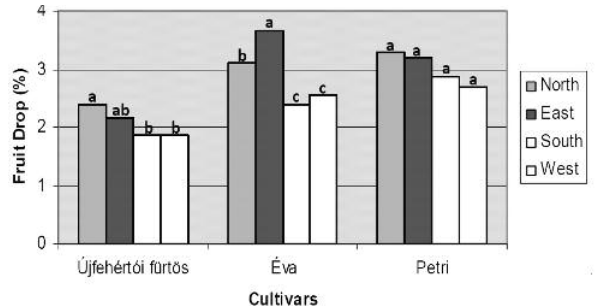
Figure 5B. Fruit drop of sour cherry cultivars on different direction of the tree